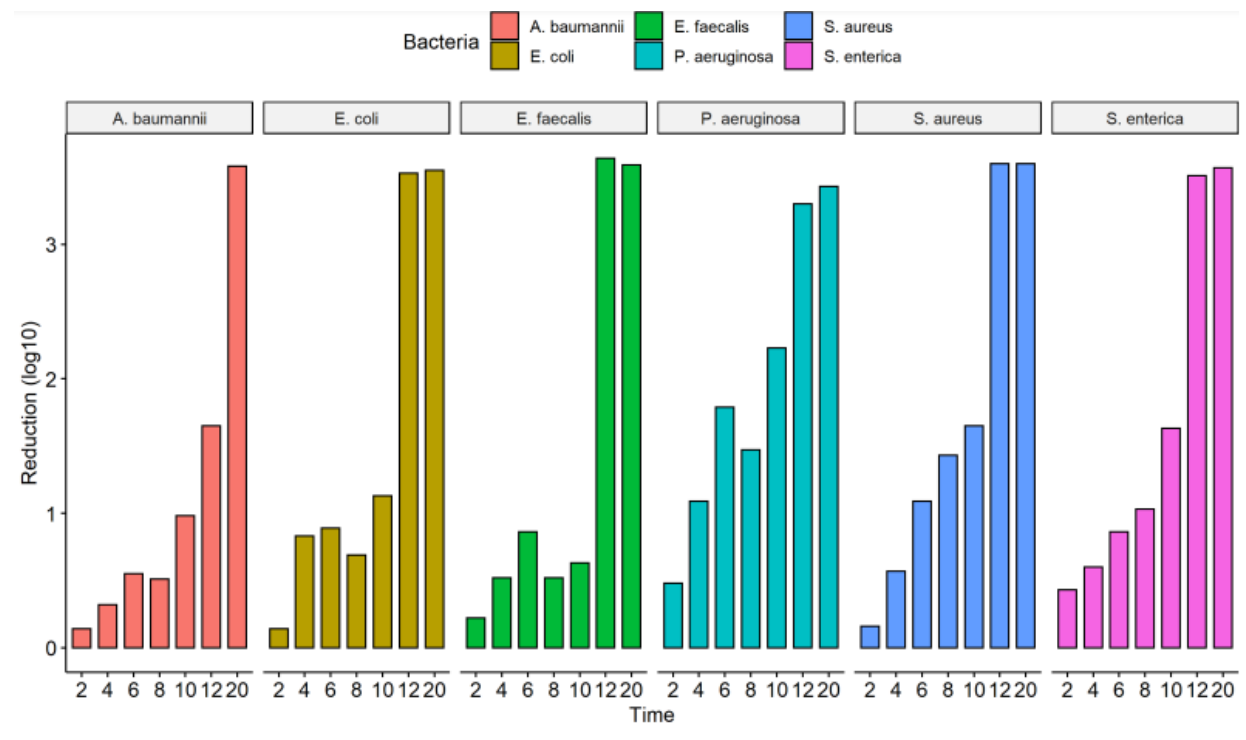
Figure 2. Efficacy of the UV-C system in reducing the number of colony-forming units of the ATCCs strains used and expressed in log 10 reduction of CFU/mL; CFU, colony forming units. Table 2. Reduction in CFU/mL counts after exposure to the UV-C system in ATCCs bacterial strains ( S. aureus (ATCC 6538), P. aeruginosa (ATCC 15442), S. enterica (ATCC 10708), E. coli (ATCC 25922), A. baumannii (ATCC 19606) and E. faecalis (ATCC 29212)). The number of CFU/mL was quantified in bacterial suspensions of ATCCs strains (1:100 dilution) after exposure to the UV-C system for 2, 4, 6, 8, 10, 12, and 20 s and in the control group (no treatment).